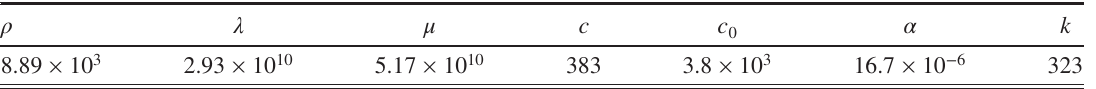
TABLE I. Parameters of the beam intercepting material presented in the nomenclature. All values are in SI units and at room